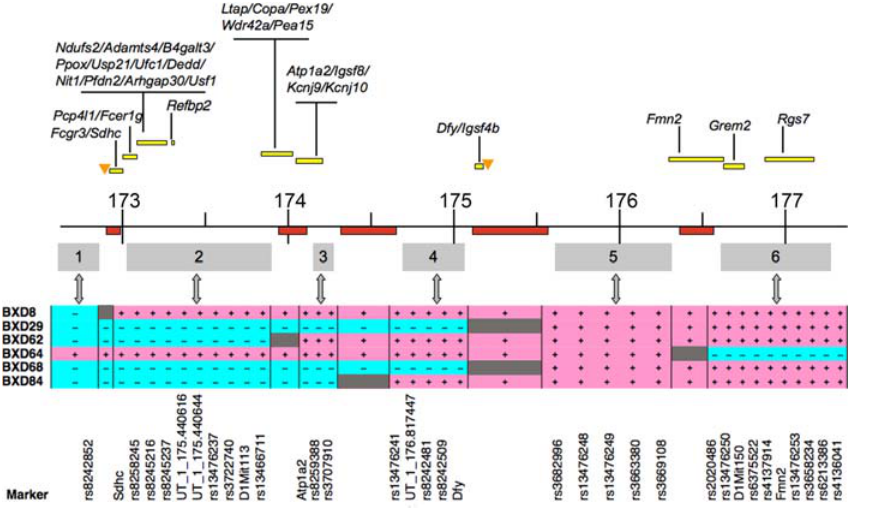
Figure 2. Haplotype maps of Qrr1 recombinant BXD strains. BXD8, BXD29, BXD62, BXD64, BXD68, and BXD84 have recombinations in Qrr1 . B haplotype is assigned blue ( 2 ), D haplotype is assigned pink ( + ), and recombination regions are shown in grey. The Qrr1 interval (in Mb scale) is shown above and approximate positions of recombination are highlighted (red). The recombinant strains collectively divide Qrr1 into six segments (labeled 1–6), and provide six sets of informative markers. Markers are shown below and approximate positions of candidate genes (yellow bars) and tRNA clusters (orange triangles) are indicated.